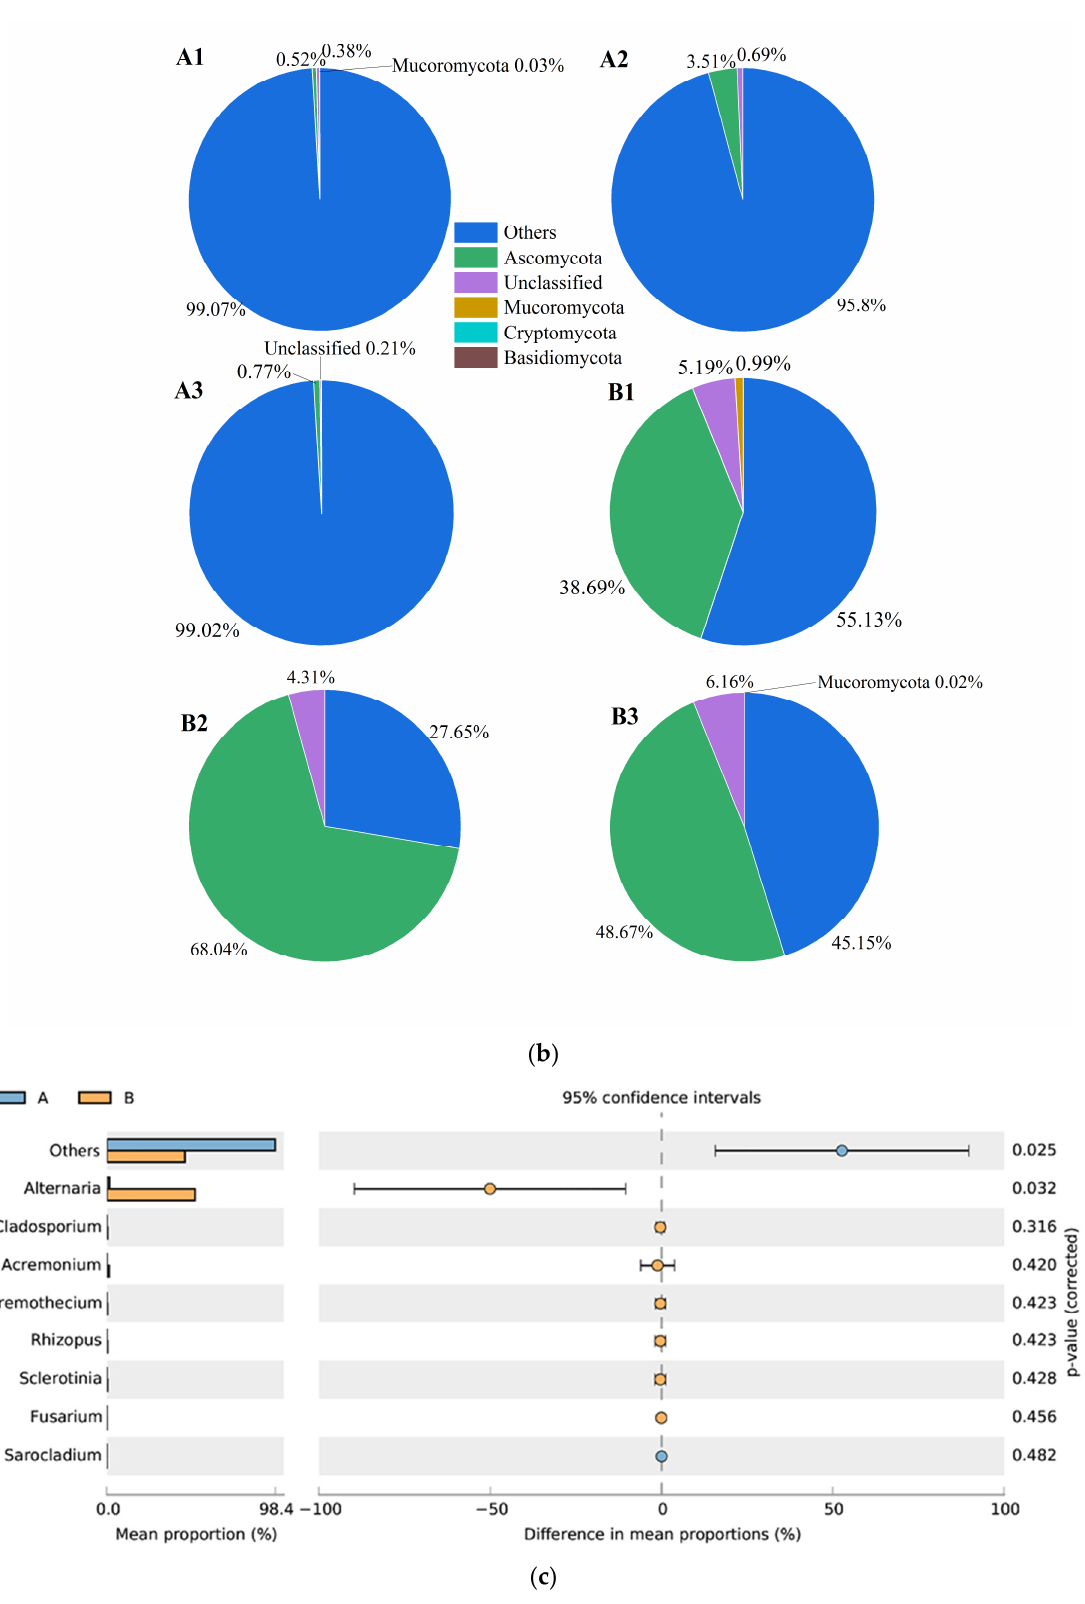
Figure 1. Differences in the composition and pollution degree in post-storage internally mildewed and normal fungus–seed symbiosis across three seasons. Group A (A1–A3), unmildewed (2018–2020); group B (B1–B3), mildewed (2018–2020). ( a ) Genus-level community composition; ( b ) phylum-level community composition; ( c ) STAMP analysis of groups A and B.